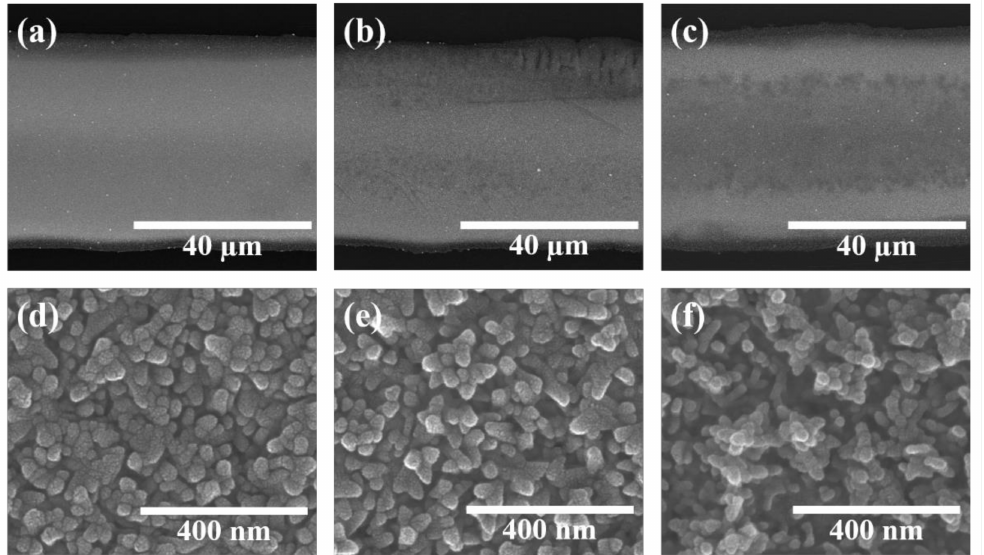
Figure 2. SEM images of silver electrodes fabricated at di ff erent curing temperatures; Low-magnification images at ( a ) 150 ◦ C, ( b ) 170 ◦ C, and ( c ) 190 ◦ C; High-magnification images at ( d ) 150 ◦ C, ( e ) 170 ◦ C, and ( f ) 190 ◦